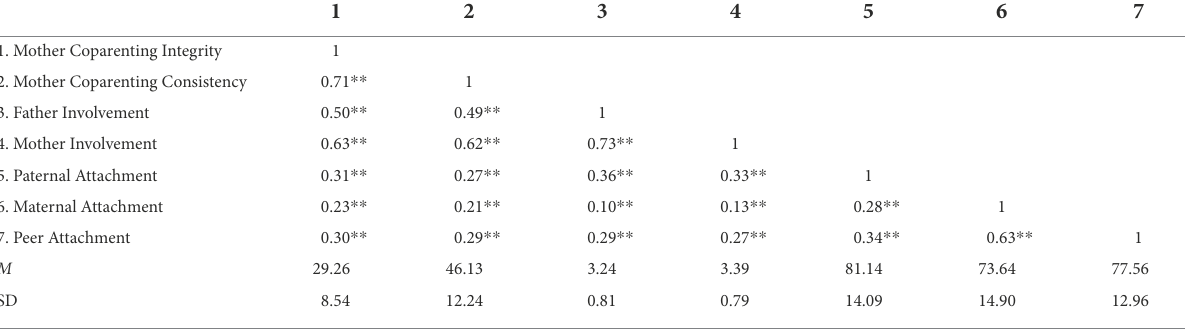
TABLE 1 Pearson correlations and descriptive statistics of the main study variables ( N =